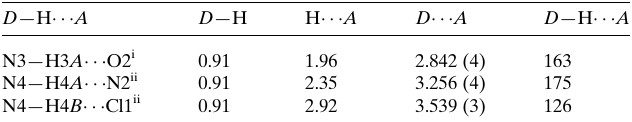
Table 1 Hydrogen-bond geometry (A˚ , (cid:3) ).